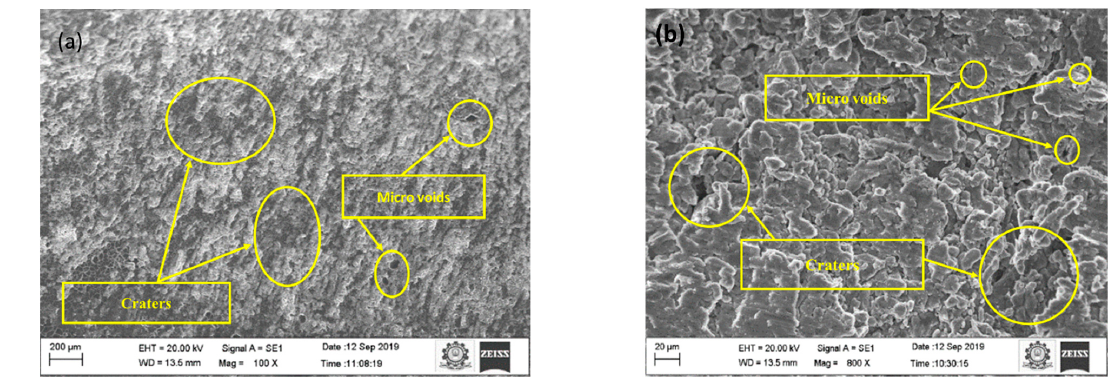
Figure 4. SEM image of machined surface at ( a ) 100X and ( b ) 800X at optimal conditions.